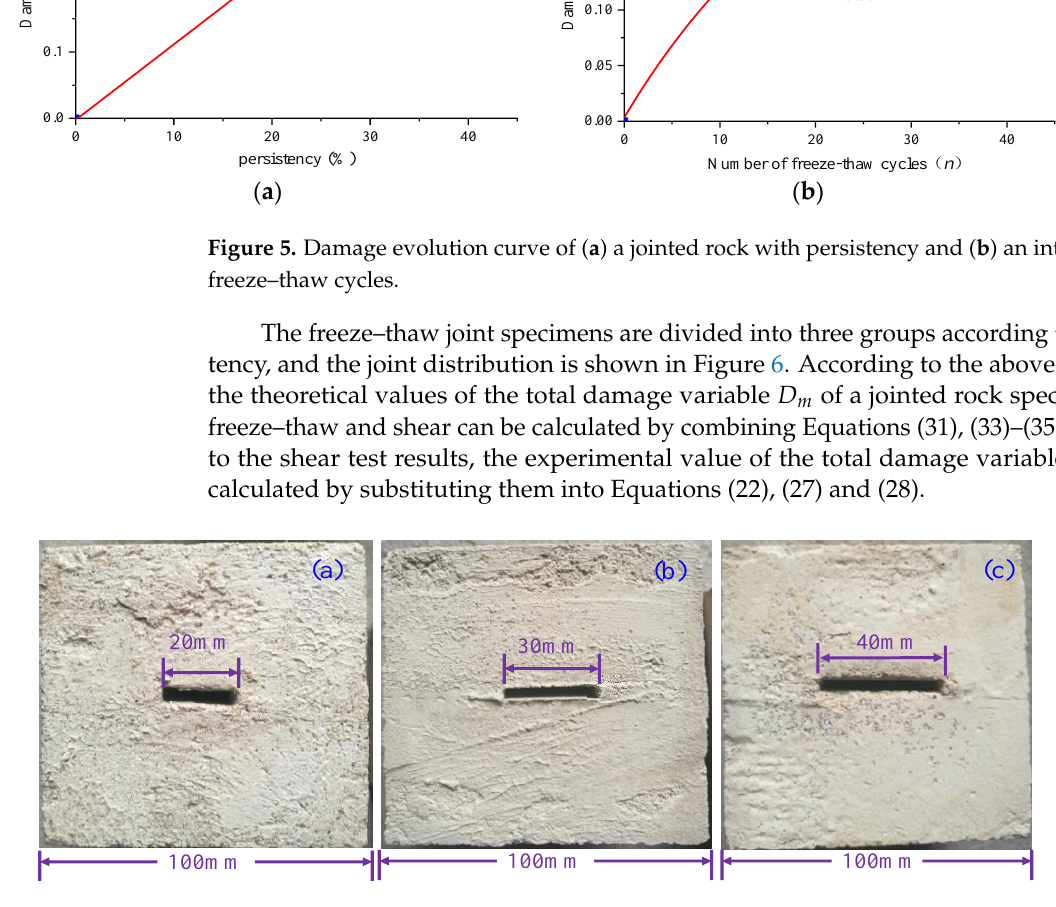
Figure 6. Joint distribution form of freeze–thaw specimens with ( a ) persistency = 20%, ( b ) persistency = 30%, and ( c ) persistency = 40%.